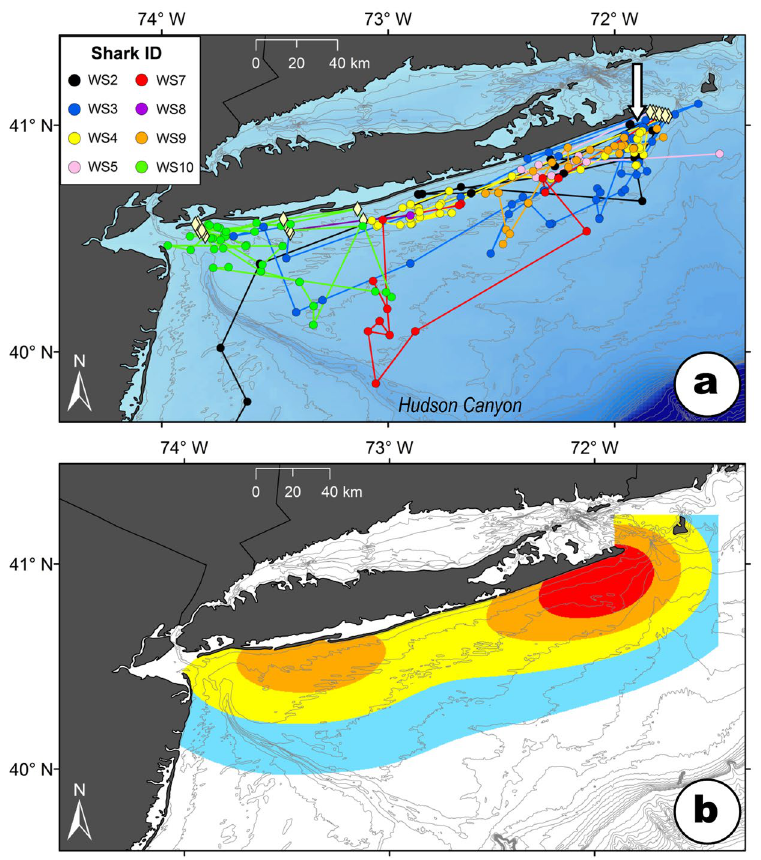
Figure 2. Tracks of eight YOY white sharks ( a ) and kernel utilization distributions (blue = 95%; yellow = 75%; orange = 50%; red = 25%) of the tagged sharks ( b ) off Long Island, New York, during August through October, 2016. The arrow indicates the tagging location. Diamond symbols represent locations of acoustic receivers where YOY white sharks were detected. Bathymetric contours (gray lines) are in 10 m